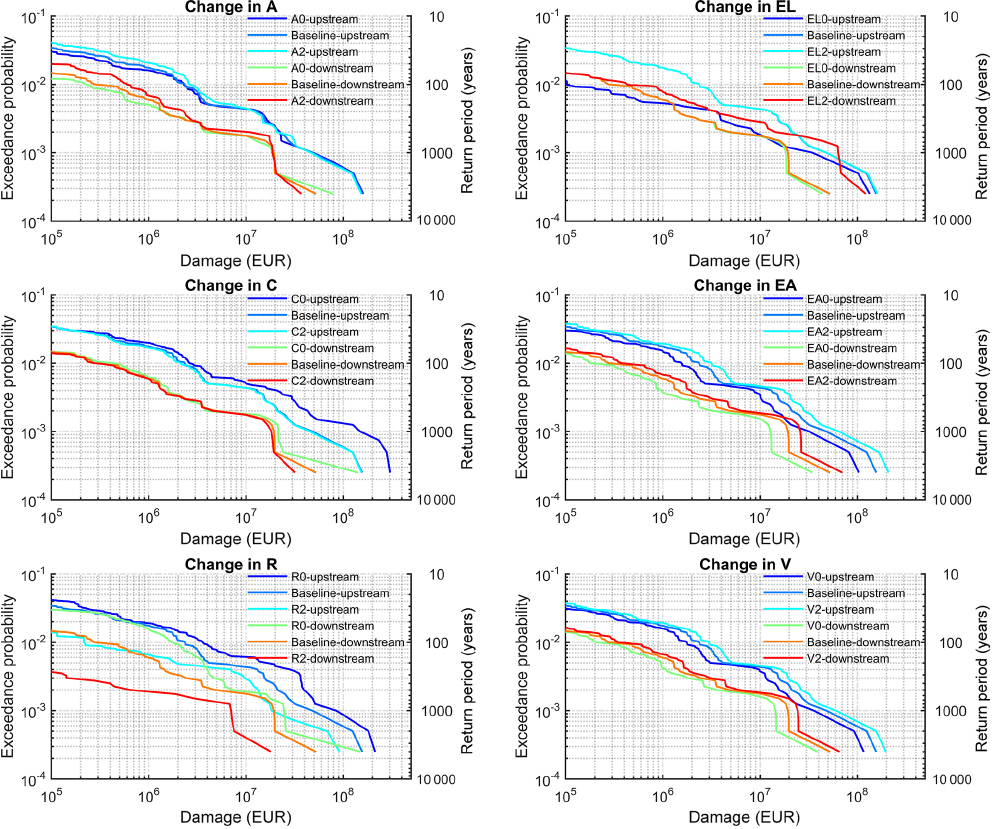
Figure 7. Risk curves for changes in six components, atmosphere (A), catchment (C), river system (R), land use (EL), asset values (EA), and vulnerability (V), under baseline conditions at districts Zwickau (upstream) and Anhalt-Bitterfeld (downstream).